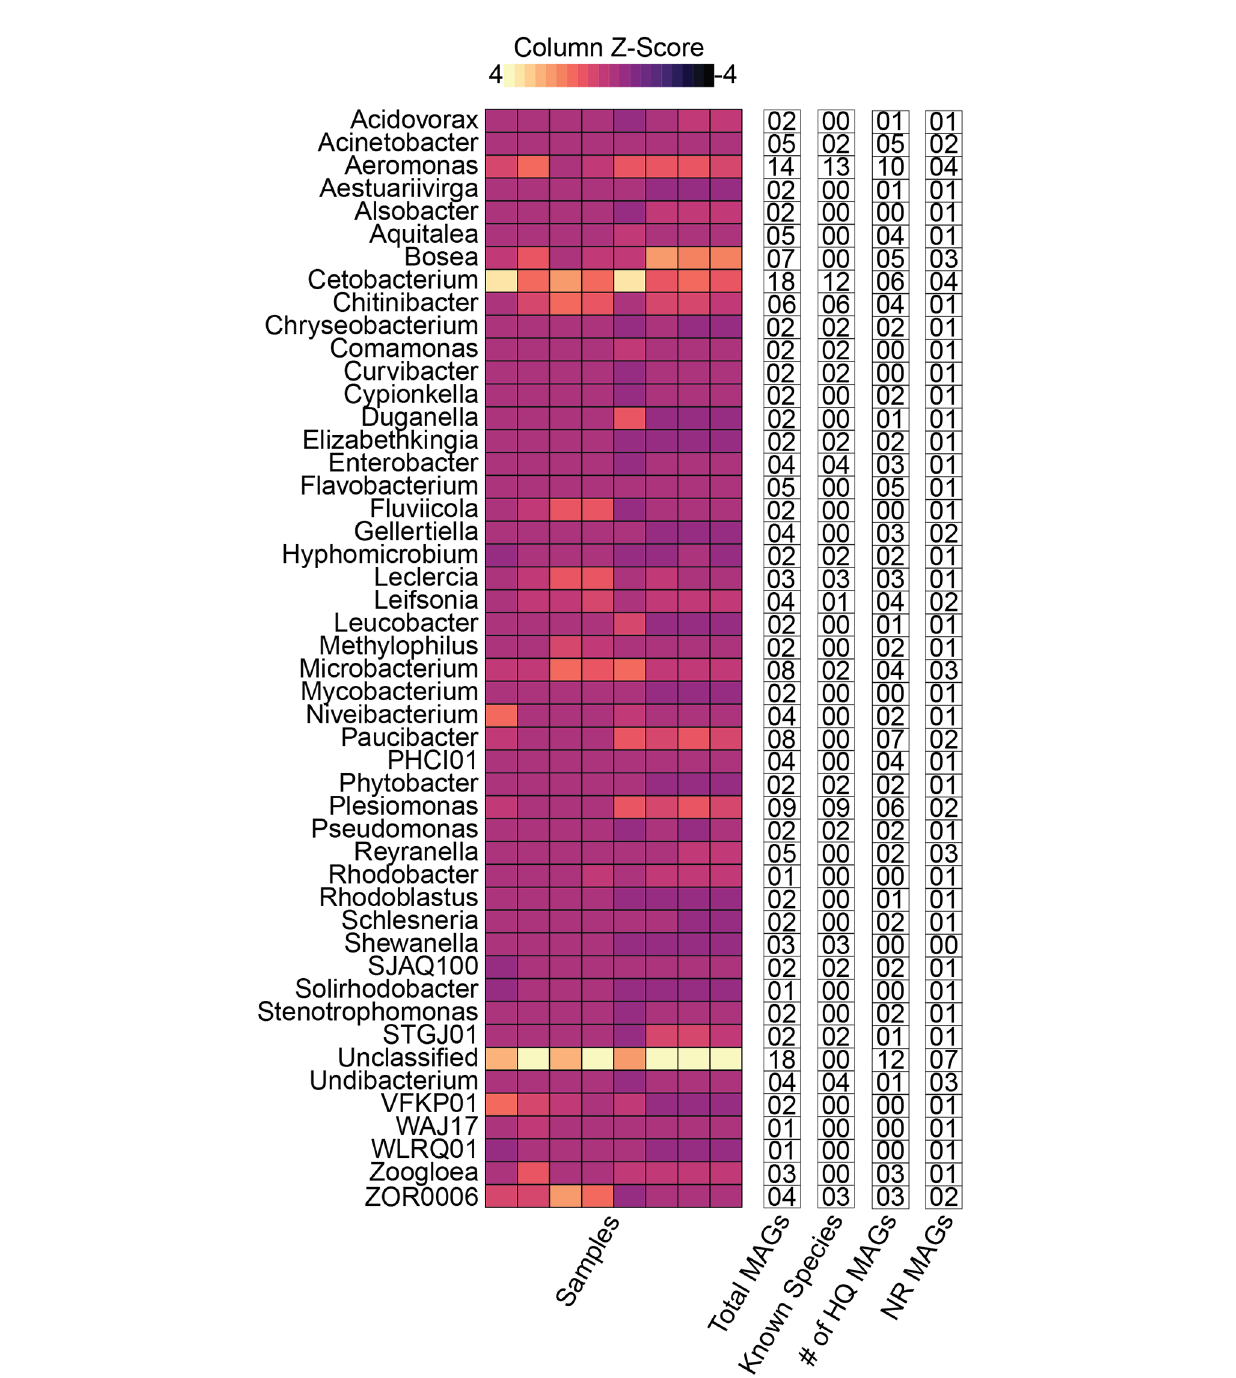
Frontiers in Cellular and Infection Microbiology |